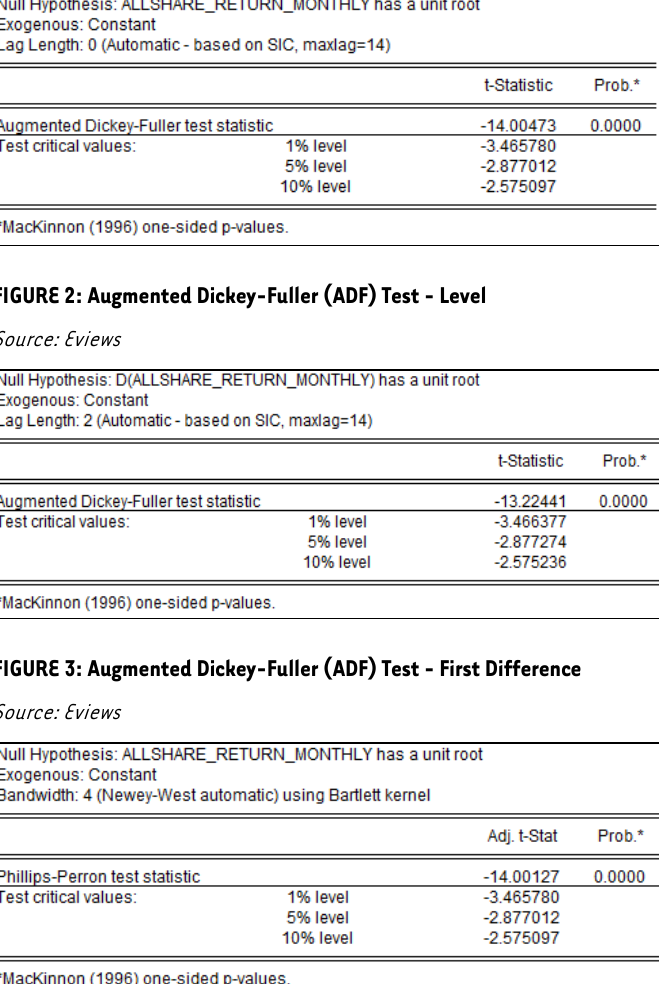
FIGURE 4: Phillips-Perron (PP) Test - Level Source: